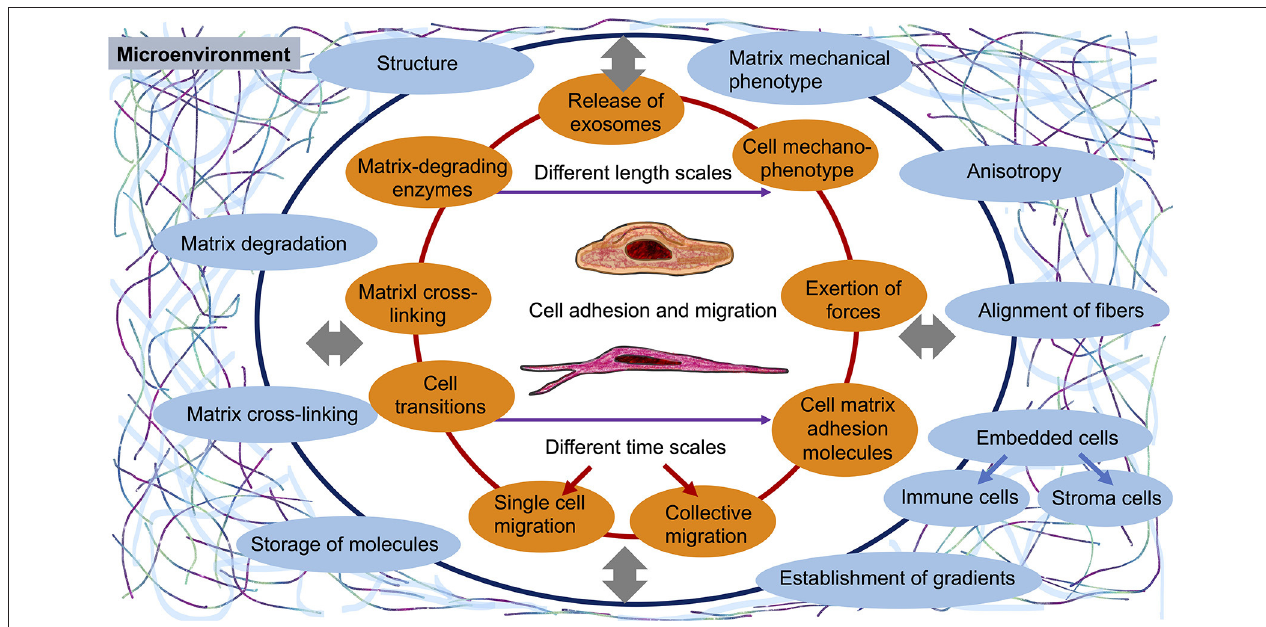
FIGURE 1 | Existing interactions between cells or a collection of cells and the microenvironment during the adhesion and migration of cells. The current gaps represent new frontiers for cell adhesion and migration research. There is a mutual interplay between cells and their surroundings that takes place at vastly different length scales and depends dynamically on time (different time